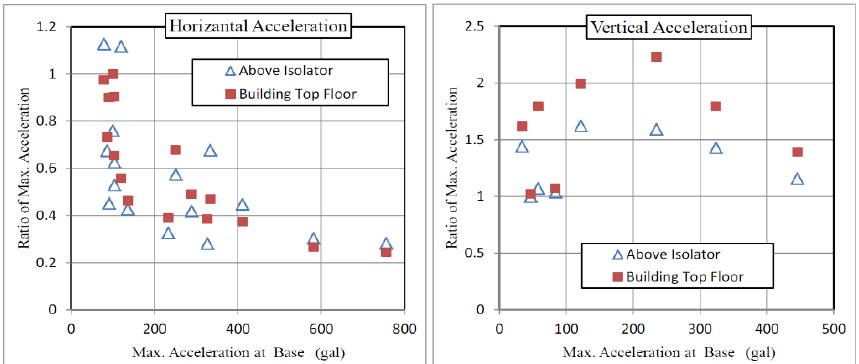
Figure 19. Ratios of peak horizontal and vertical accelerations in the 2011 Tohoku-Oki earthquake (after [65]) .